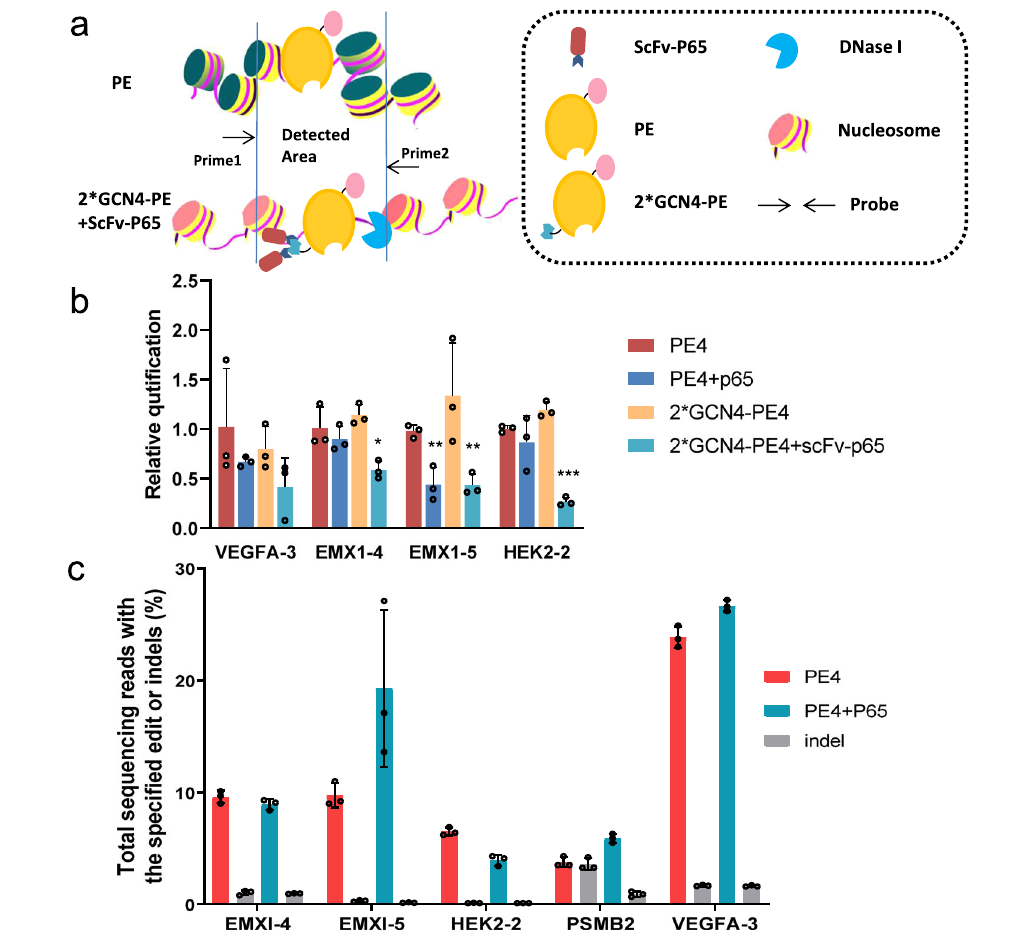
Fig.4|RecruitmentofP65promoteschromatinaccessibilityattargetgenome loci. a Schematic of functional mechanism of P65 recruited prime editors and DNaseI digestionassays. b Low-inputDNaseI digestionassayswereperformed for thedetectionofchromatinaccessibilityatfourgenomicsitesinHEK293Tcells.Bars represent the mean of n =3 independent replicates. The error bars in all fi